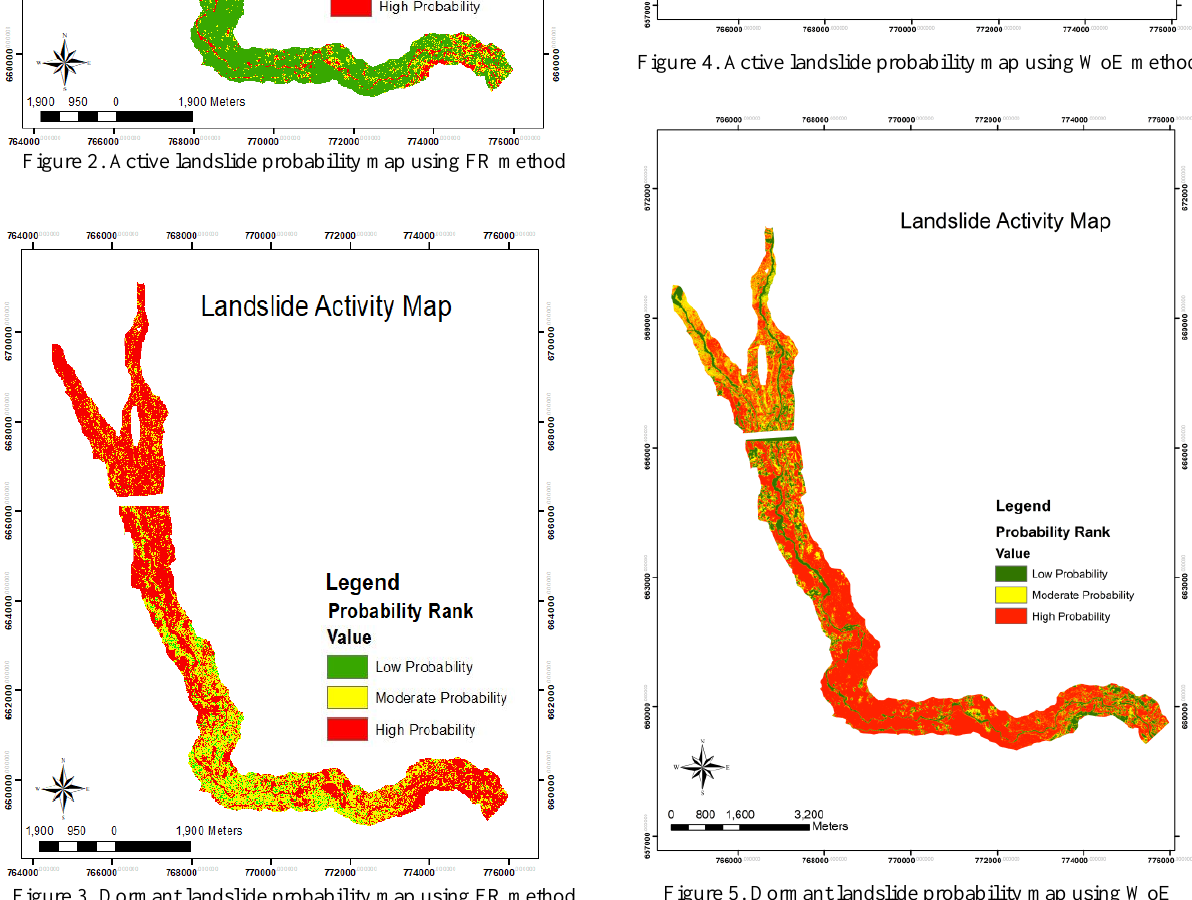
Figure 3. Dormant landslide probability map using FR method